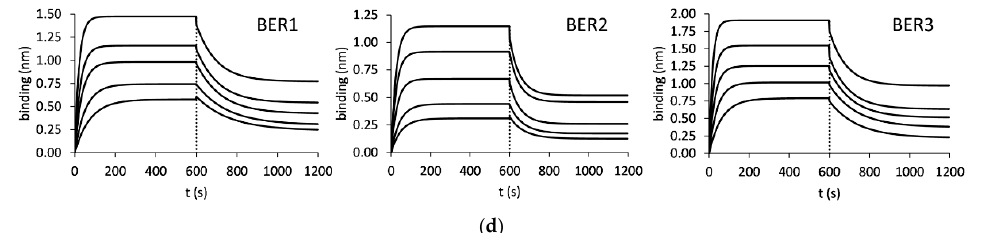
Figure 2. Anti-CD59 antigen-binding Fc fragments (Fcabs) from initial selections of Fcab libraries: ( a ) HPLC-SEC chromatography of derived mAb 2 molecules in native conditions (MWS: molecular weight standard); ( b ) ELISA with coated CD59; ( c ) Competition of biotinylated HuMax-20 (HX)-BER3 mAb 2 with HX-BER1, HX-BER2 and HX-BER3; ( d ) Biolayer interferometry measurement of response to immobilized CD59: HX-BER1 to 3 were applied in 2-fold dilution steps starting from 1 µM. RX: rituximab, TRA: trastuzumab. Table 1. Number of CD20 and CD59 molecules per cell of Raji, ARH-77, Daudi, and SK-BR-3 cell lines determined with QIFIKIT ® .